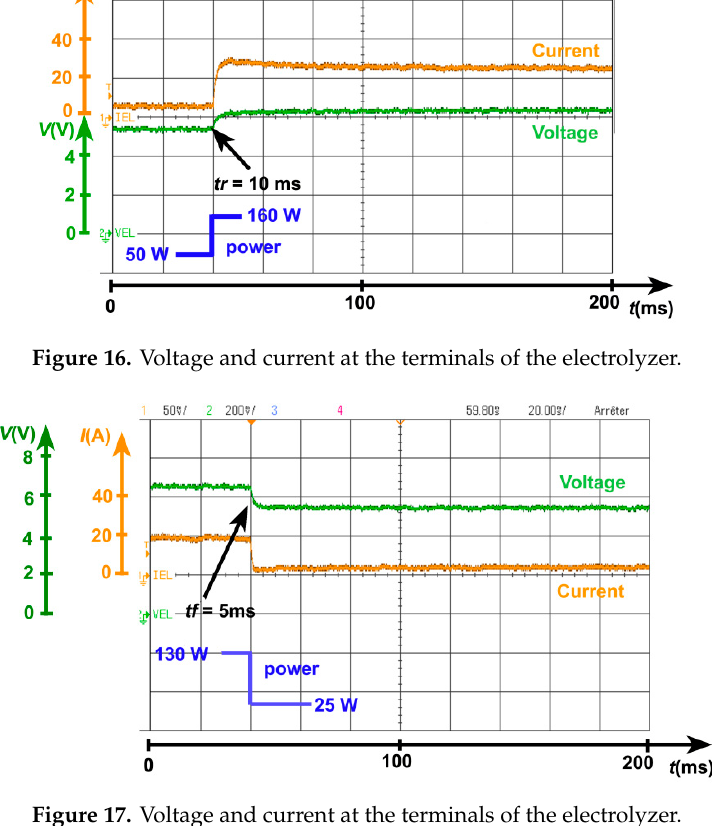
Figure 17. Voltage and current at the terminals of the electrolyzer.